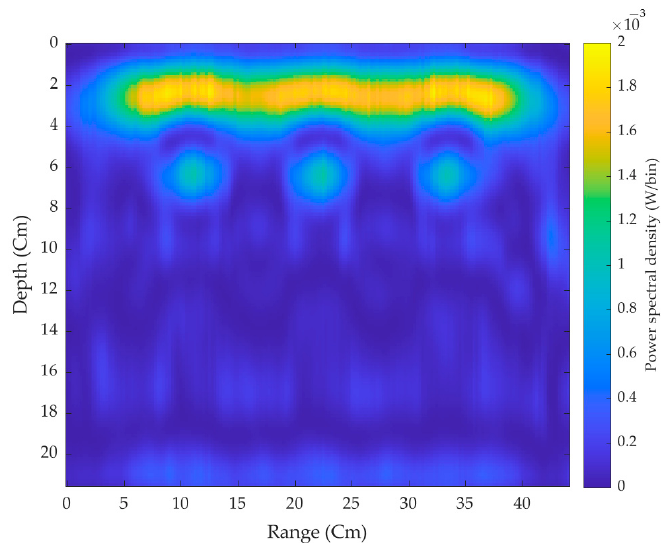
Figure 12. 2-D cross-surface scanned image without the target.